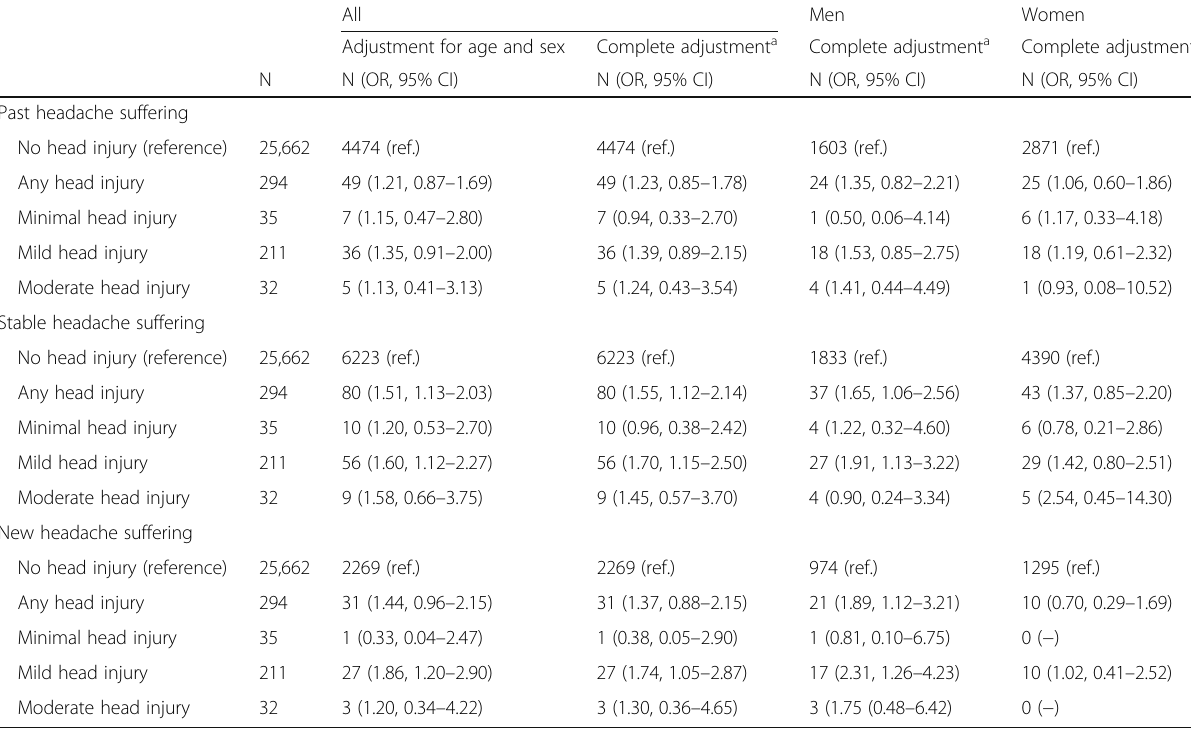
Table 2 Multivariate regression analyses of the associations between head injury and relative headache status in HUNT3 versus HUNT2 with regard to suffering from headache only All Men Women